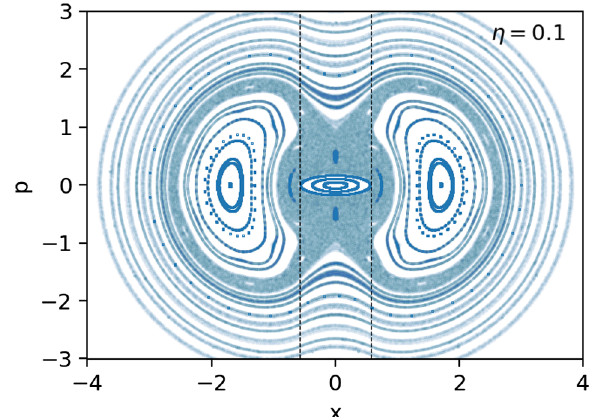
FIG. 7. Stroboscopic plot of particles at every minimum of the envelope which is indicated by the black dashed line. The tune depression ratio and the initial mismatch are η ¼ 0 . 1 and X ð 0 Þ ¼ 0 . 577